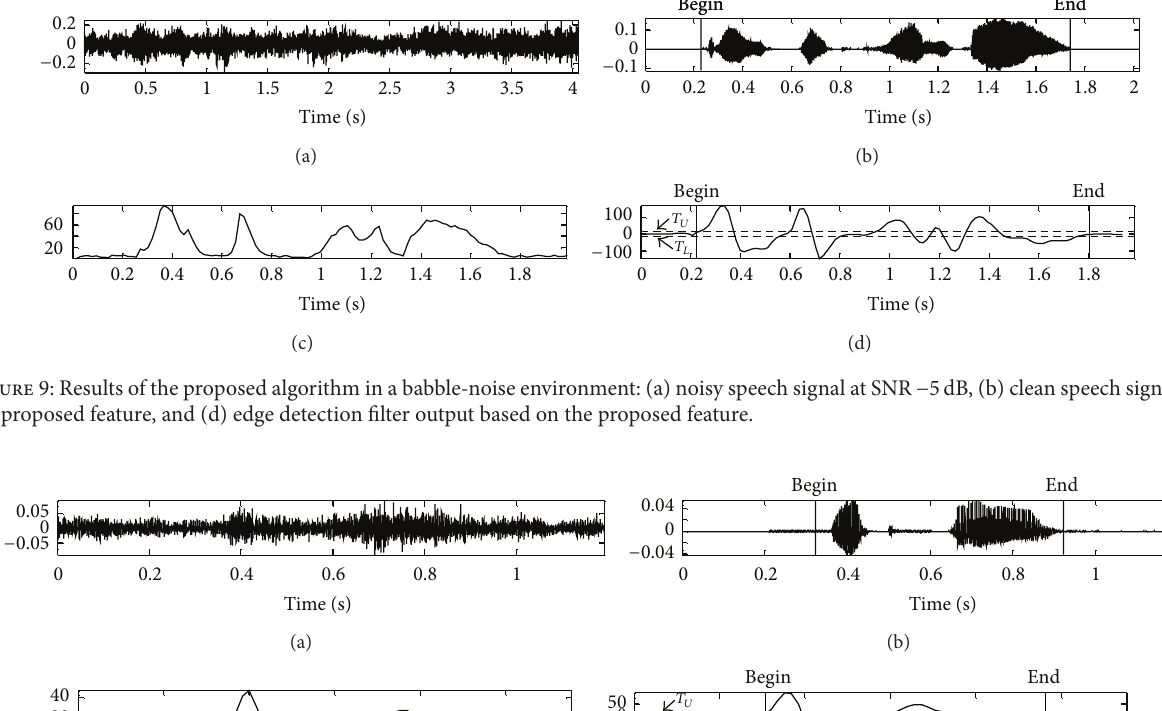
Figure 10: Results of the proposed algorithm in a restaurant - noise environment: (a) noisy speech signal at SNR − 5dB, (b) clean speech signal, (c) the proposed feature, and (d) edge detection filter output based on the proposed